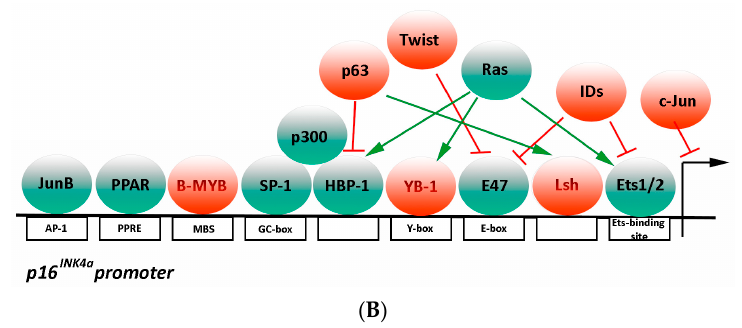
Figure 1. Epigenetic and transcriptional regulation of p16 INK4a . ( A ) Epigenetic regulation of p16 INK4a —The genomic INK/ARF locus is depicted as a bold line, with exons indicated by colored vertical lines (not drawn to scale). The coding regions of INK4b ( CDKN2B ) are shown in red, those of ARF in orange and those of INK4a ( CDKN2A ) in blue. Epigenetic repressors (red) and activators (green) have the opposite function in INK/ARF locus regulation; ( B ) Transcriptional activators and repressors of p16 INK4a —The p16 INK4a promoter is depicted as bold line with binding sites indicated by white rectangles (not drawn to scale). Expression of p16 INK4a requires the action of transcription factors (green) that recruit and/or facilitate RNA polymerase association with the promoter. Transcriptional repressors (red) have an opposite function.